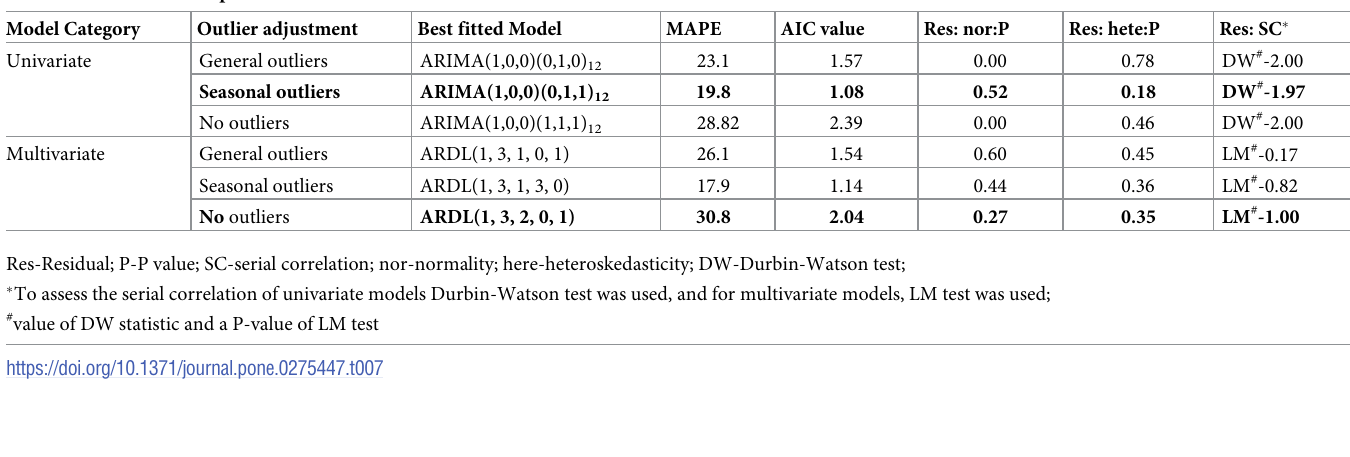
Table 7. Final model